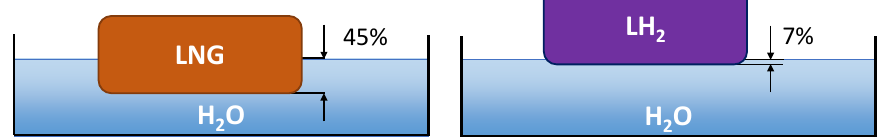
Figure 4. Illustration of penetration depth for LNG and LH 2 on a water